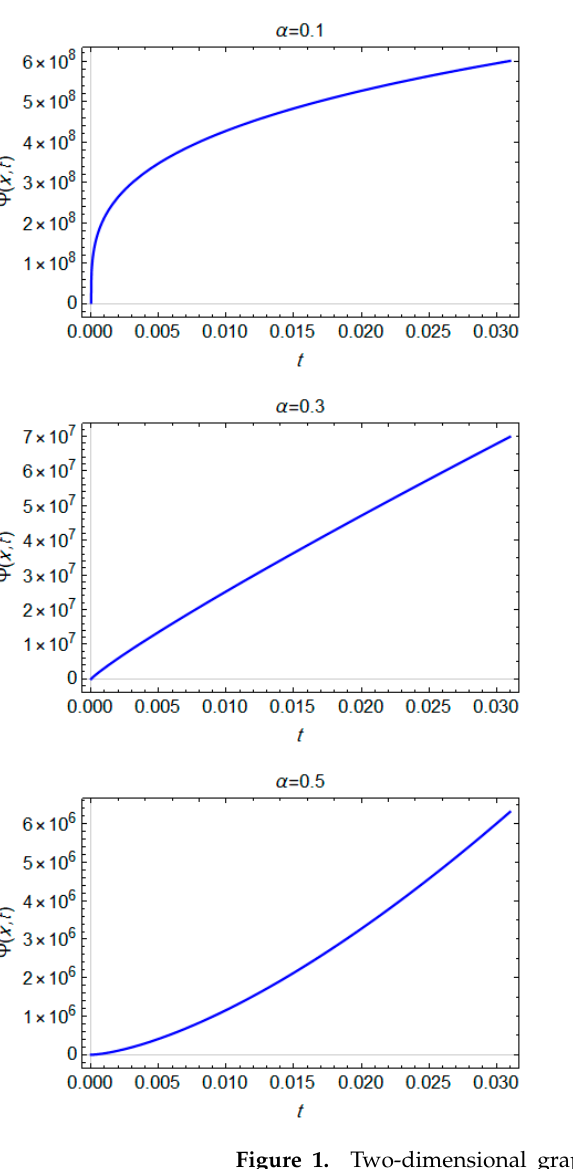
Figure 2. Three-dimensional graphs of neutron flux 𝜓(𝑥, 𝑡) with 𝜓 (cid:2868) (𝑥) = 𝑥 (cid:2870) for α = 0.1, 0.2, 0.3, 0.4 and 0.5 (colored online). Two-dimensional graphs of neutron flux 𝜓(𝑥, 𝑡) for α = 0.1, 0.2, 0.3, 0.4, and 0.5 (colored online). The plotted profile of the neutron fluxes for different values of 𝛼 ( 𝛼 = 0.1, 0.2, 0.3, 0.4 and 𝛼 = 0.5 ) in both cases {𝜓(𝑥, 0) = 1 and 𝜓(𝑥, 0) = 𝑥 (cid:2870) } , as presented in Table 1 and Figures 1 and 2, shows that the results were in agreement with the Adomian decomposition method [10]. As observed from the tables and figures, the Laplace residual power series method used to solve the time-dependent fractional neutron diffusion equations with delayed neutrons provided us with more details about the neutron flux in non-Gaussian diffusion for different selected times. The importance of this work was manifested by uncovering the behavior of the flux in the presence of the delayed neutrons that affected them (this phenomenon is known as anomalous diffusion). This flux can be expressed mathematically by the solution of the time-dependent fractional neutron diffusion equations, as shown in Equation (42). It must be noted that the time-dependent flux increased with time in both the studied numerical cases [9,10,12].